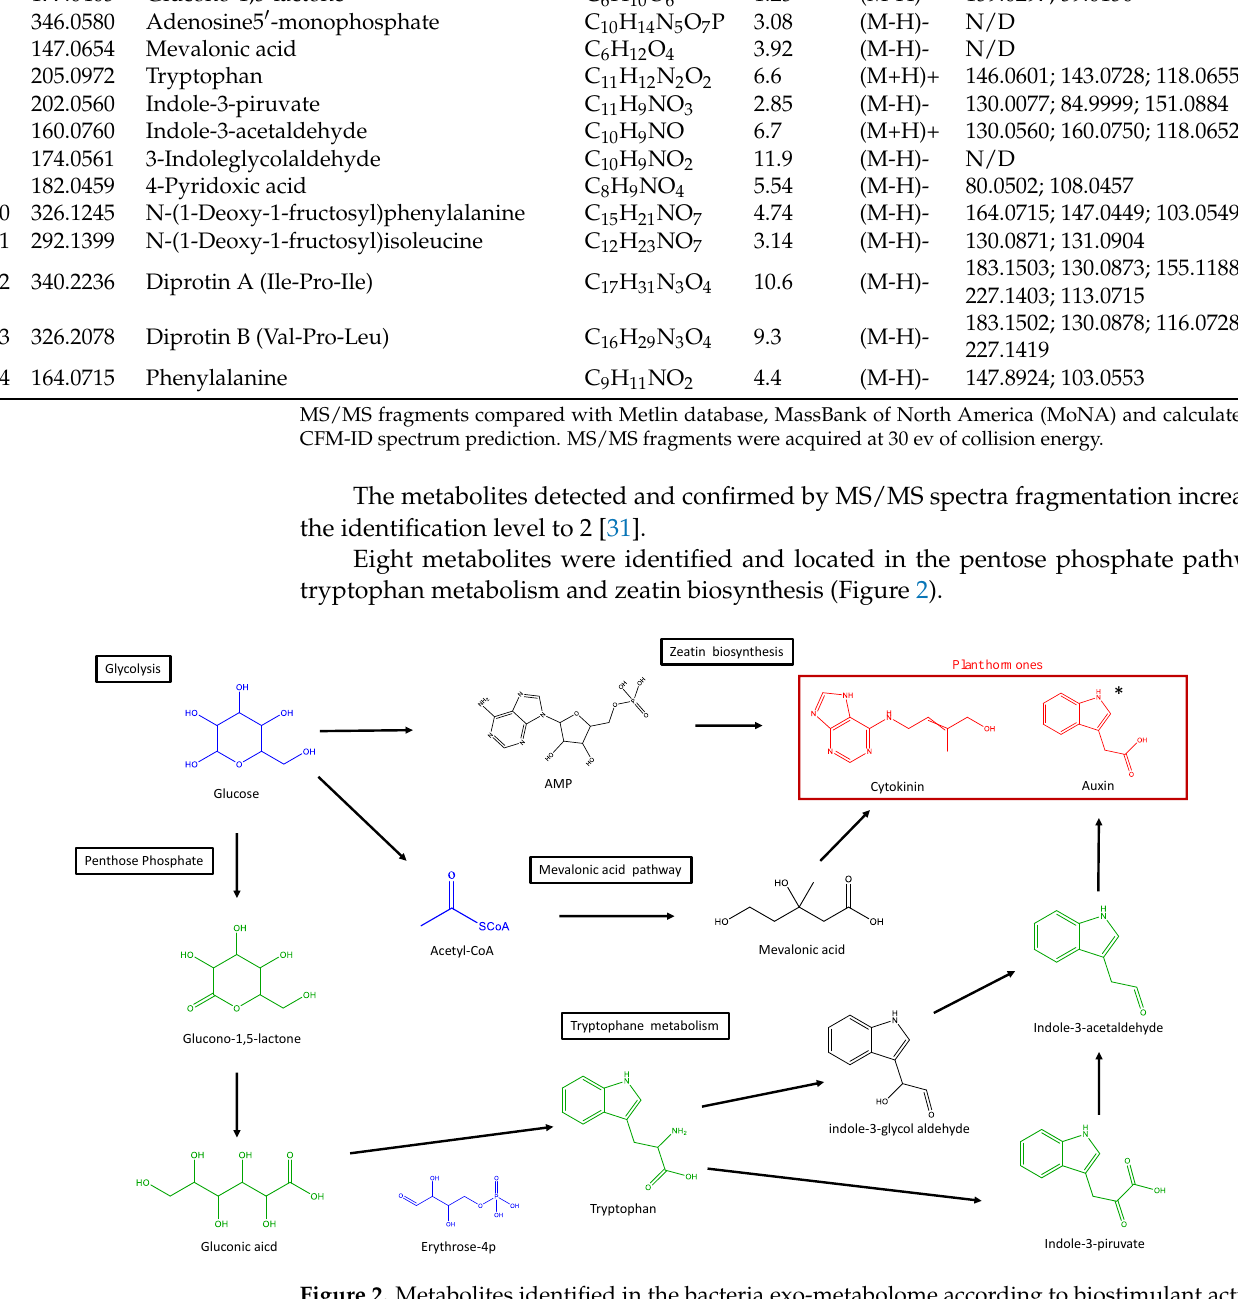
Figure 2. Metabolites identified in the bacteria exo-metabolome according to biostimulant activity level and found in the biosynthesis of plant hormones. Black metabolites: metabolites identified; green metabolites: metabolites identified and confirmed by MS/MS spectra fragmentation; blue and red metabolites: metabolites not detected. * Compared with authentic standard .